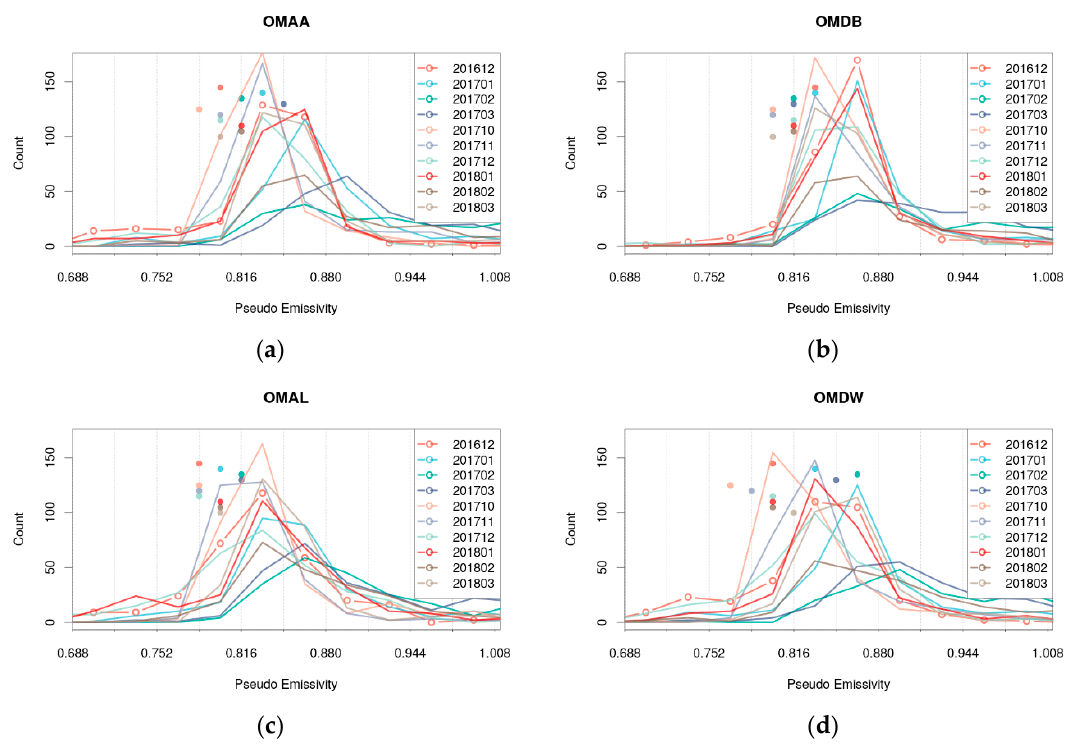
Figure 5. Histogram of ems(3.9) at ( a ) Abu Dhabi (OMAA) ( b ) Dubai (OMDB), ( c ) Al Ain (OMAL) and ( d ) Al Maktoum (OMDW). Monthly threshold values are indicated by closed circles on the pseudo-emissivity plots. Placement on the y -axis is arbitrary for these dots in order to avoid concealment from overlap.